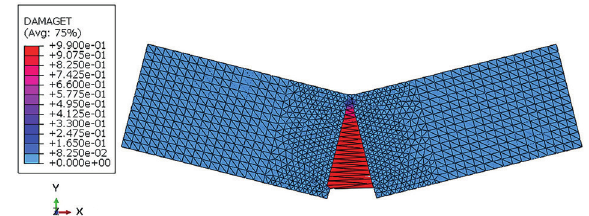
Fig. 24. Tensile damage in three-point notch beam with large size